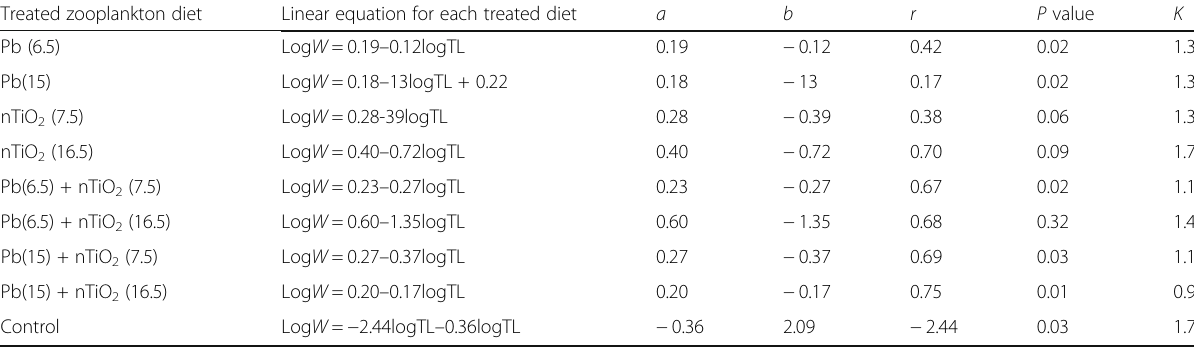
Table 2 Estimated parameters of total length-body weight relationships and condition factor for C. gariepinus Treated zooplankton diet Linear equation for each treated